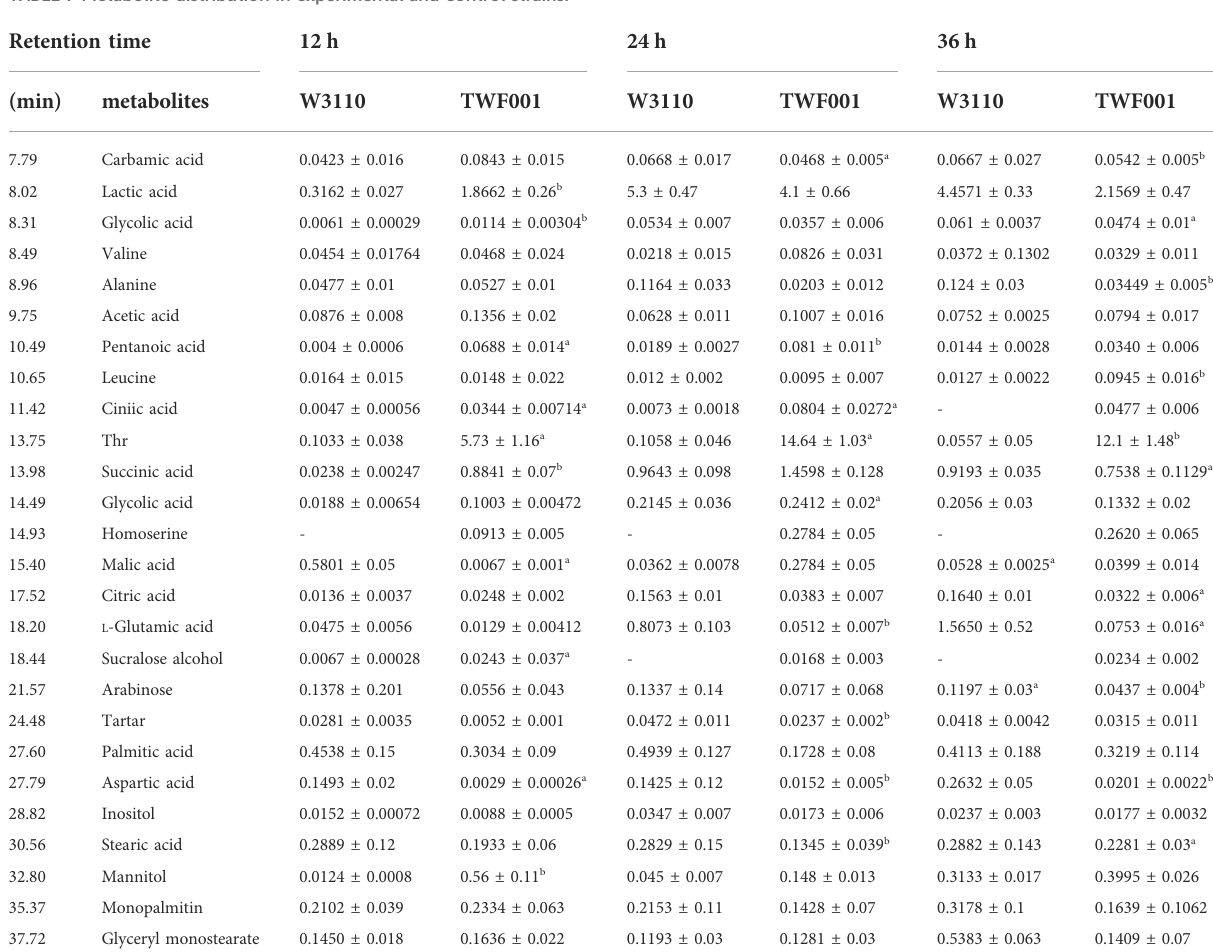
TABLE 7 Metabolite distribution in experimental and control